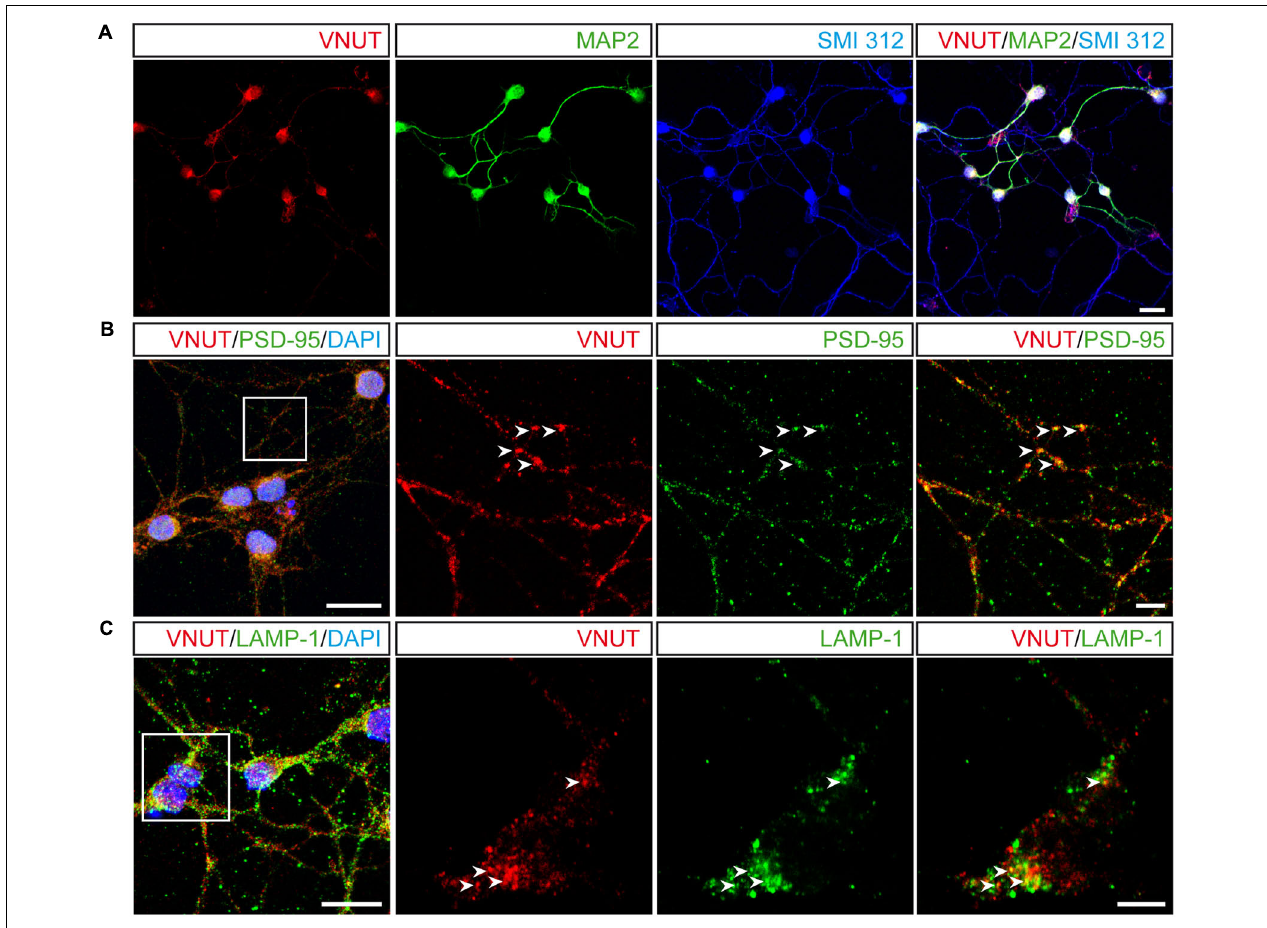
FIGURE 3 | Subcellular localization of VNUT in cerebellar granule cells. (A) Representative confocal images showing the immunofluorescence for VNUT (red), MAP2 (green) and SMI 312 (blue). Scale bar: 20 µ m. (B) Confocal images of double immunofluorescence for VNUT (red) and PSD95 (green). Scale bar: 15 µ m. Insets represents higher magnifications to show the co-localization (yellow) of VNUT (red) and PSD95 (green). Arrowheads indicated co-localized immunostaining for the two proteins. Scale bar: 5 µ m. (C) Representative confocal images of double immunofluorescence for VNUT (red) and LAMP-1 (green). Scale bar: 15 µ m. Insets represents higher magnifications to show co-localization (yellow) of VNUT (red) and LAMP-1 (green). The arrowheads indicate co-localization of the immunostaining for the two proteins. Scale bar: 5 µ